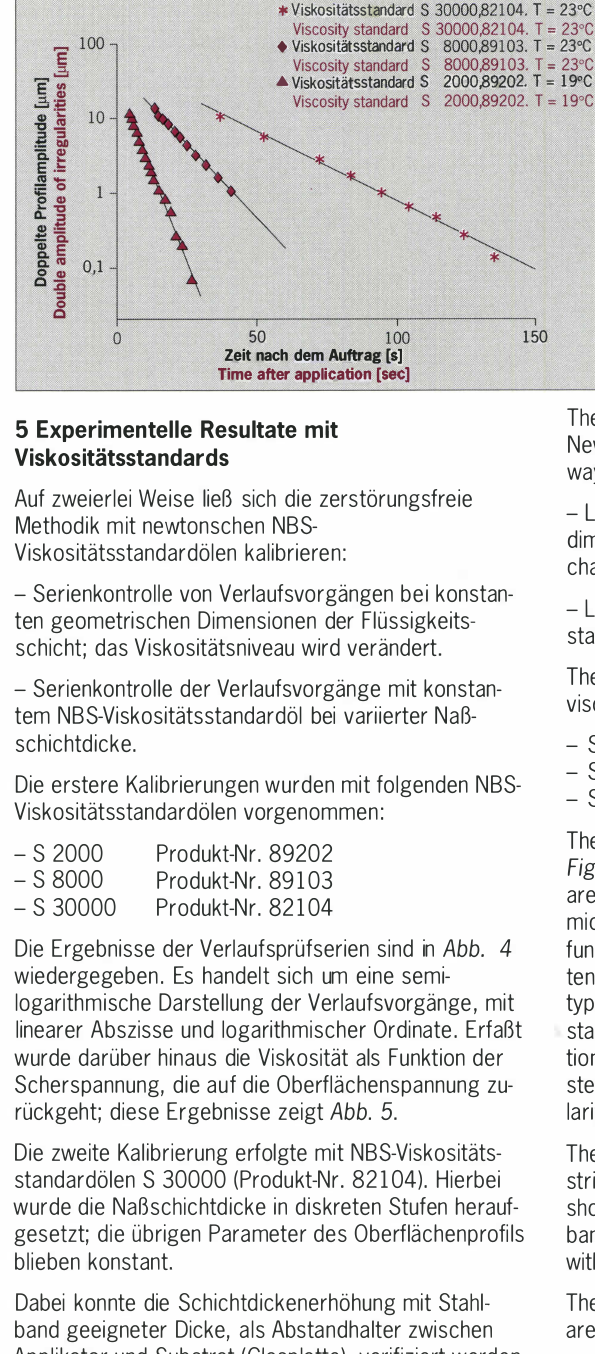
Fig. 5: Viscosity as a function of shear stress for different NBS viscosity standards, showing Newtonian